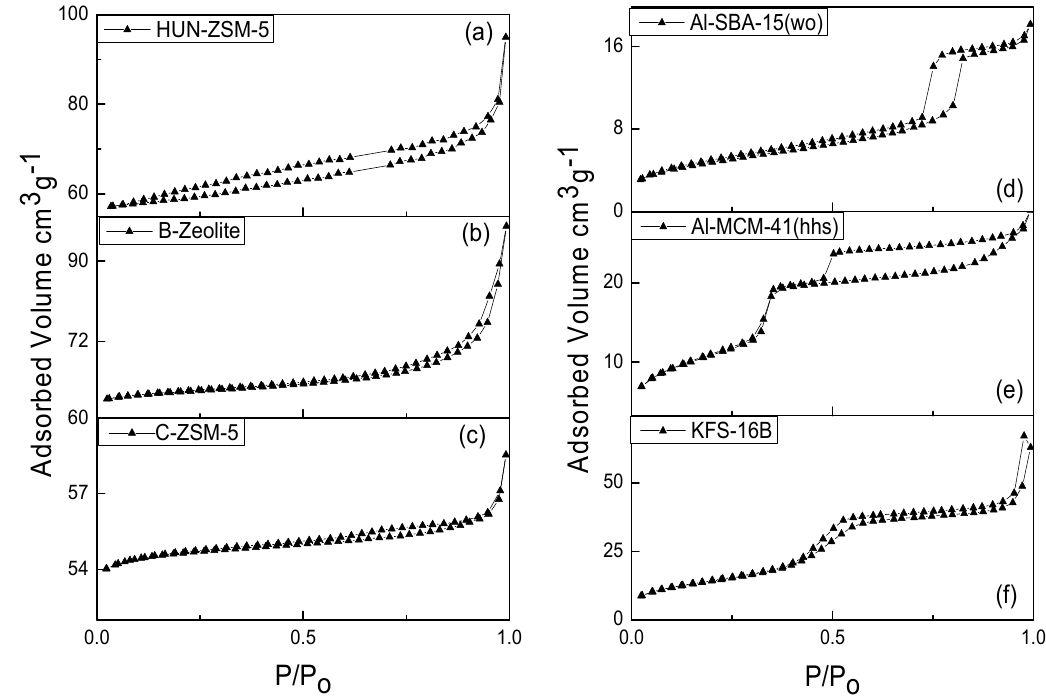
Figure 3. Nitrogen gas adsorption/desorption isotherms of the catalysts: ( a ) HUN-ZSM-5; ( b ) B-Zeolite; ( c ) C-ZSM-5; ( d ) Al-SBA-15(wo); ( e ) Al-MCM-41(hhs); and ( f ) KFS-16B. Table 2. Textural properties and acidity of different catalysts. BET: Brunauer-Emmett-Teller; n.a.: not